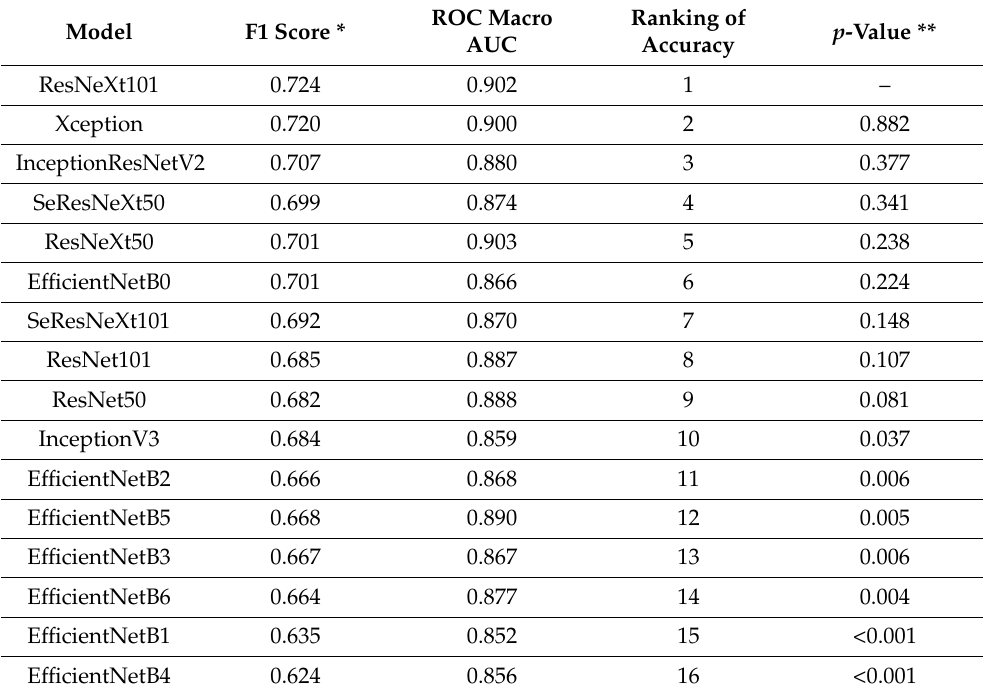
Table 5. The evaluation metrics for each of the 16 CNNs (Table 4 continued) and.significant difference test between ResNeXt101(top1) and 15 other models.